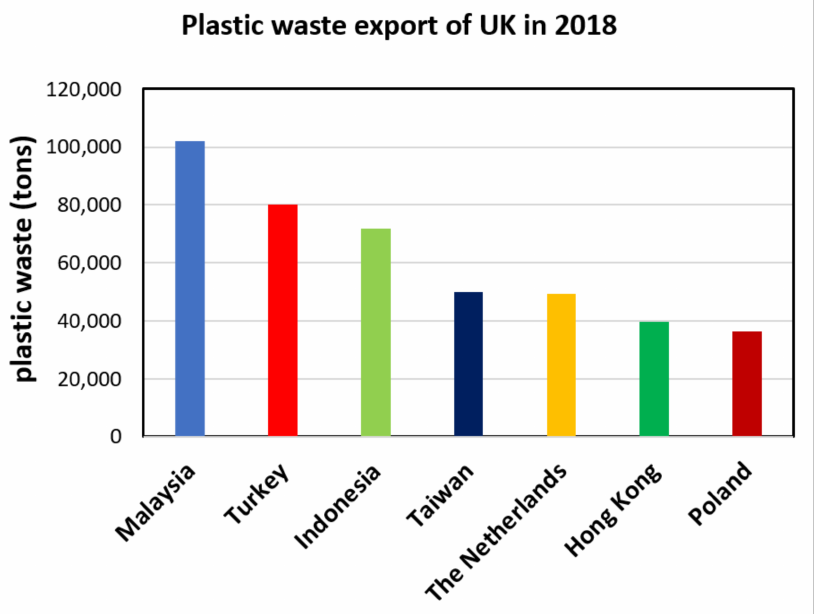
Figure 1. Top seven countries where the UK exported its plastic waste in 2018 (data from